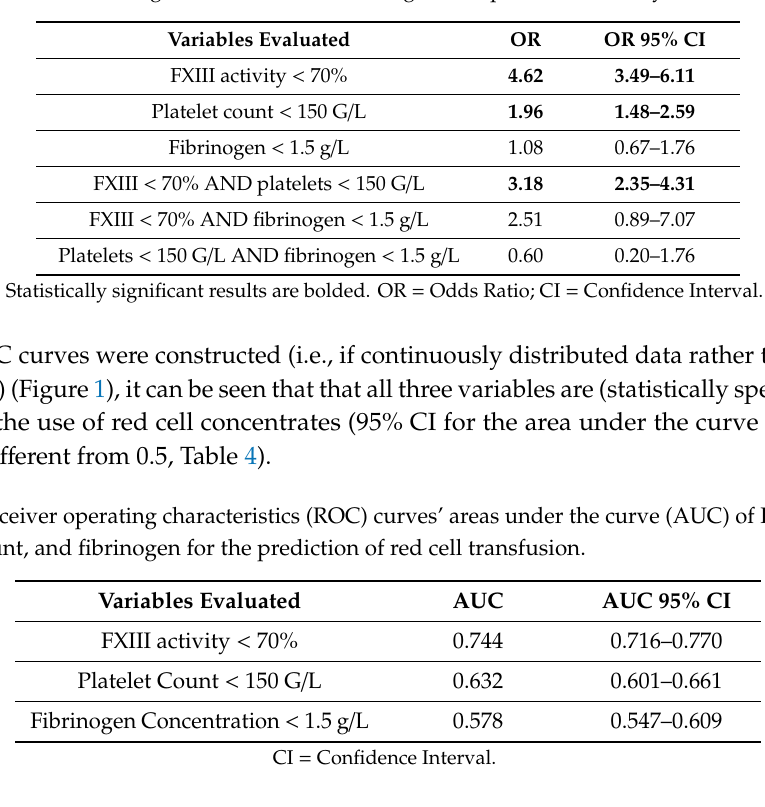
Table 3. Odds ratios for receiving red blood cells, according to a respective deficiency / combination of deficiencies.